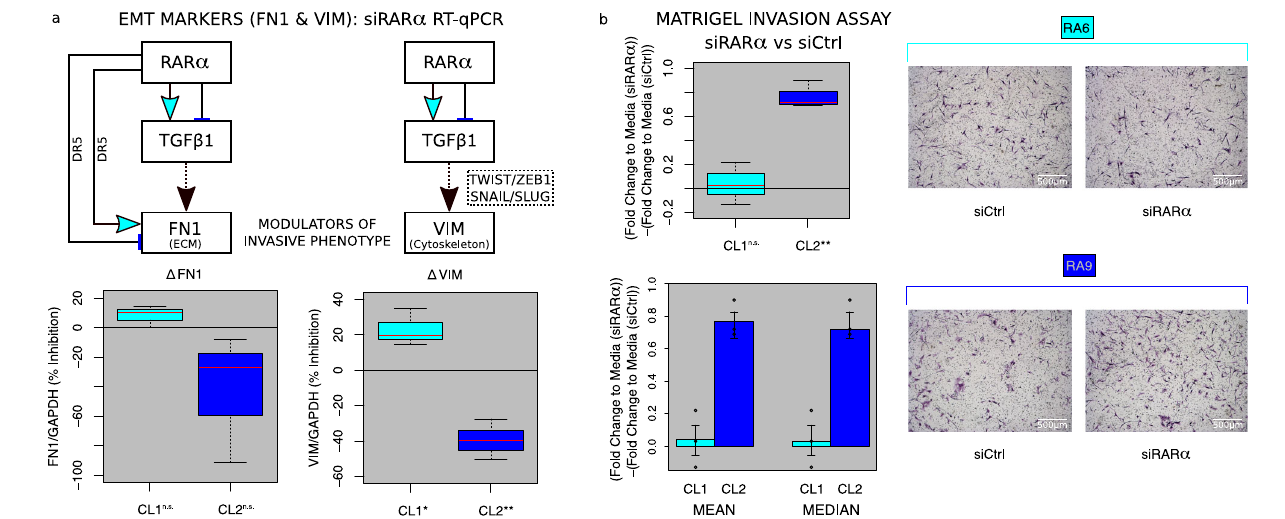
p -valuescalculatedbypairedtwo-tailedStudent ’ st-testforsiRARAvsCTL* p <0.05 ** p <0.001. b TGF β -stimulated Matrigel Invasion Assay boxplot for CL1 and CL2 ( p =0.0077) and barplot of mean and median values (error bars represent 1 stan- darddeviation). p -valuescalculatedbypairedtwo-tailedStudent ’ st-testforsiRARA vs CTL ** p <0.001. CL1 n =3 and CL2 n =3 biologically independent cell lines. Representative4×magni fi cationimagesofmigratedRAFLSinsiRAR α andsiCtrlfor two exemplar patient cell lines RA6 (CL1) and RA9 (CL2). For all box plots, red center line for median, whiskers represent maximum and minimum values, box width from quartile 1 to quartile 3. Source data are provided as a Source Data fi